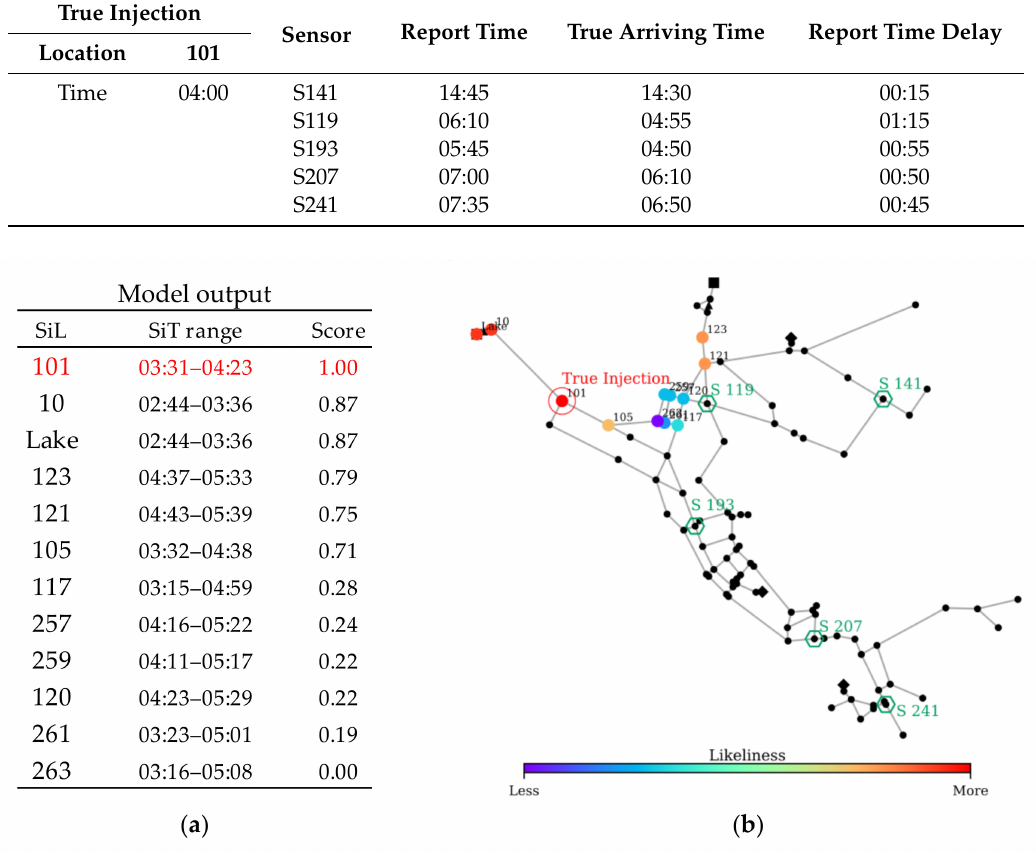
Figure 11. CPSITE simulation results of scenario 1: ( a ) Model output and ( b ) SiL